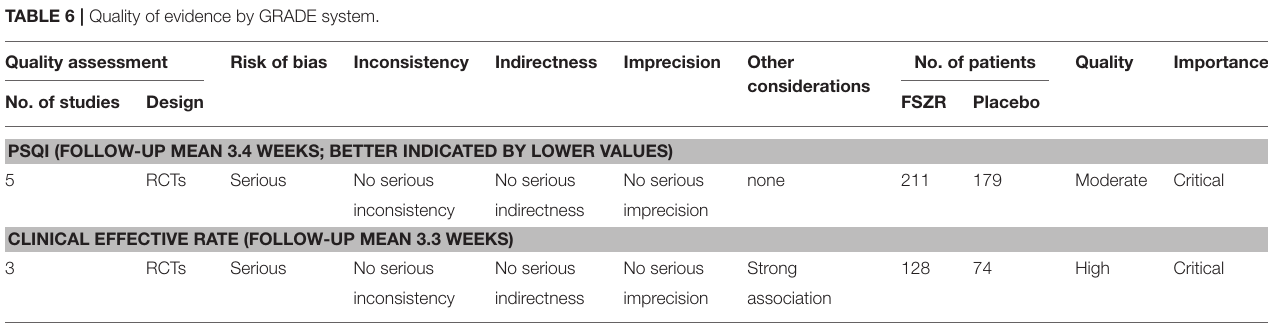
TABLE 6 | Quality of evidence by GRADE